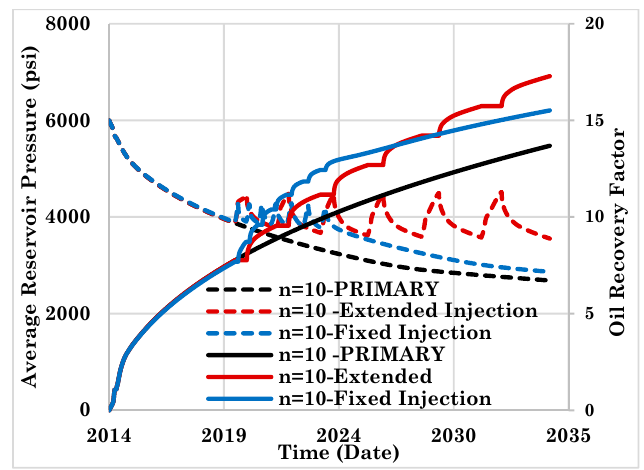
Figure 3. Dashed lines: average reservoir pressure; solid lines: oil recovery factor during CGI in both fixed and growing cycle sizes for n = 10.